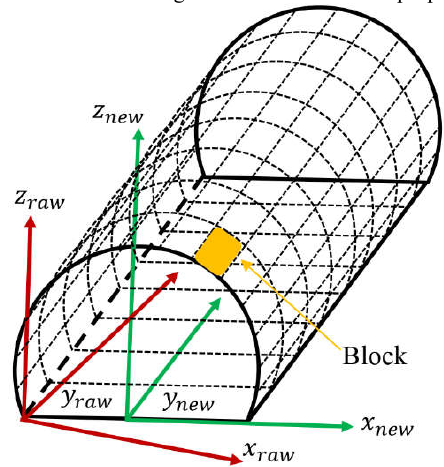
Figure 1. Workflow of the proposed method for deformation measurement in tunnels.